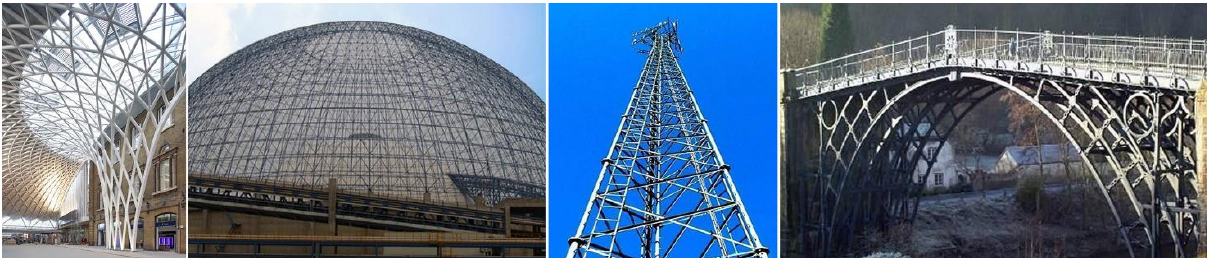
Figure 1: Different architectural types based on space grid